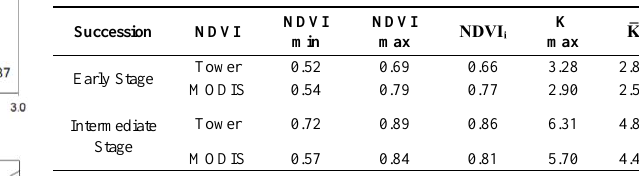
Table 1. The maximum, minimum, and seasonal changes (NDVI max , NDVI min and NDVI i ) used to find the “K” coefficient